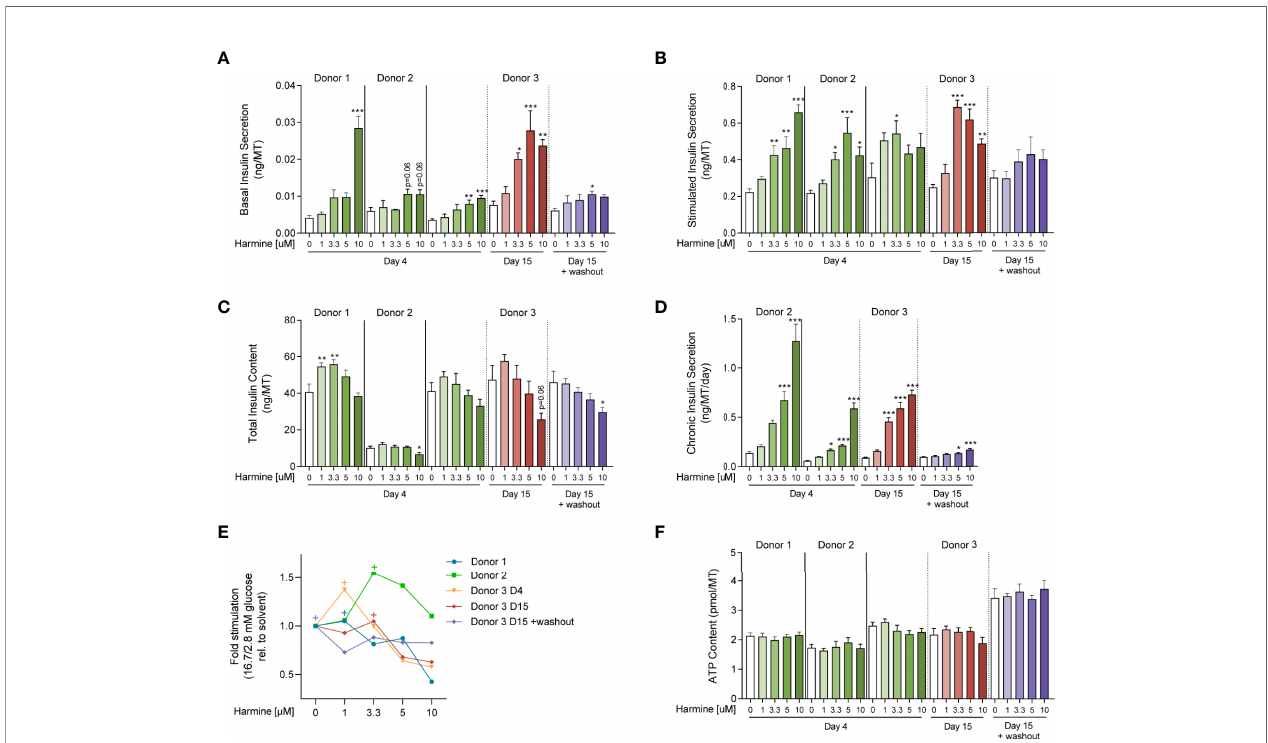
FIGURE 4 | Evaluation of harmine dose-response on human islet MT function and viability. (A) Basal and (B) stimulated insulin secretion of islet MTs treated with (A) 2.8 mM glucose or (B) 16.7 mM glucose for 2 hours (ng/MT). (C) Total insulin content of islet MTs after GSIS (ng/MT). (D) Chronic insulin secretion of islet MTs over the course of 24 – 72 hours (ng/MT/day). (E) Stimulated-to-basal fold-stimulation (16.7/2.8mM glucose). “ + ”‘ s indicate maximum fold-stimulation for each dataset. (F) ATP content of islet MTs (pmol/MT). (A – D, F) Data are represented as mean ± SEM, n = 5 – 12. Signi fi cance was determined by one-way ANOVA followed by Dunnett ’ s multiple comparisons test vs. the respective DMSO control (* p < 0.05, ** p < 0.01, *** p <